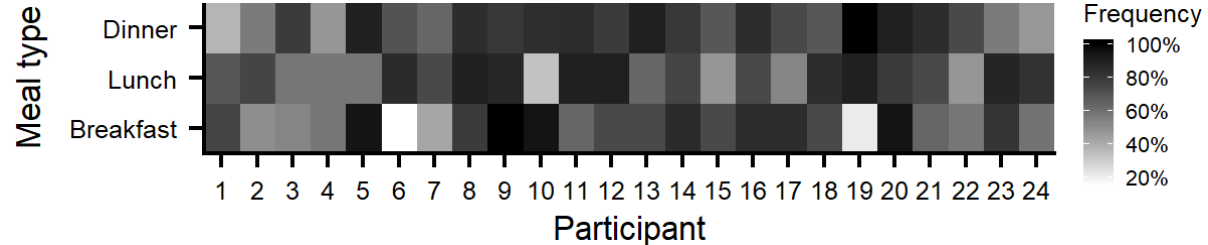
Figure 3. Frequency of meal registration per participant throughout the study, ranging from 0% to 100% per day for each main meal type.